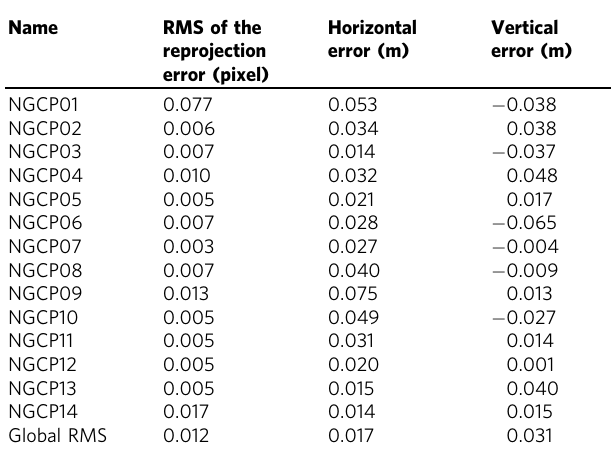
Table 5 Horizontal and vertical deviations of the GCPs for the